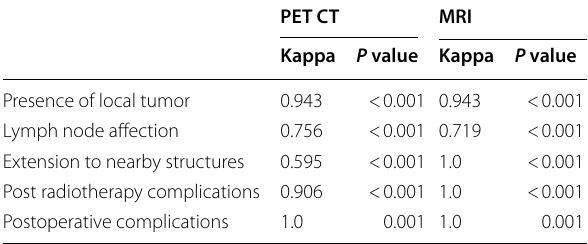
Table 5 Agreement of PET CT and MRI findings with follow-up findings